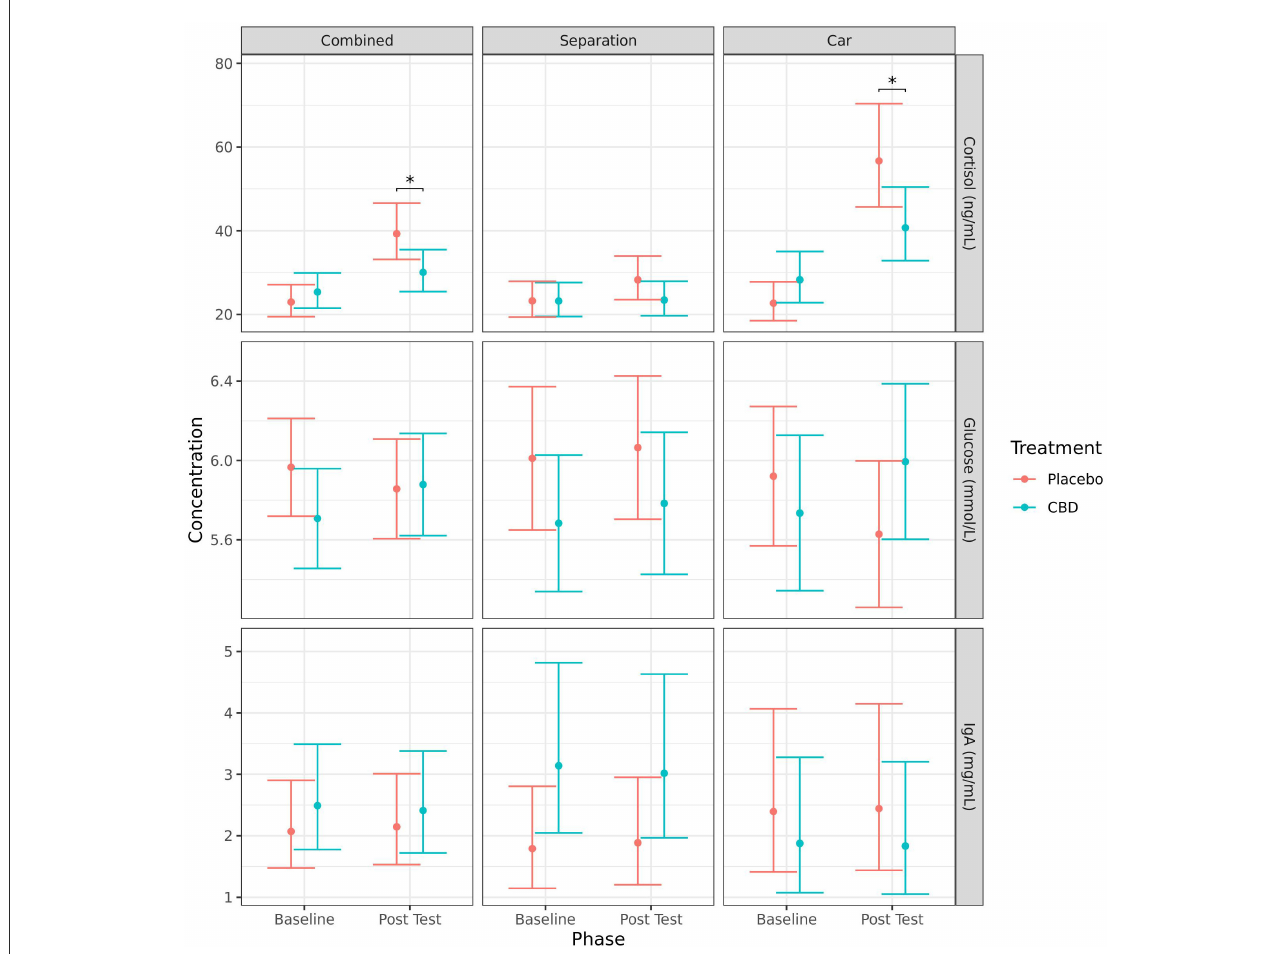
FIGURE3 Predicted mean (95% CI) serum cortisol (ng/ml), glucose (mmol/L), and IgA (mg/ml) concentrations for dogs given CBD or placebo at each phase of testing (baseline and post-stressor) based on models analyzing both stress tests combined, separation test or car test. Asterisks indicate significant differences between treatment groups within each phase. * p <